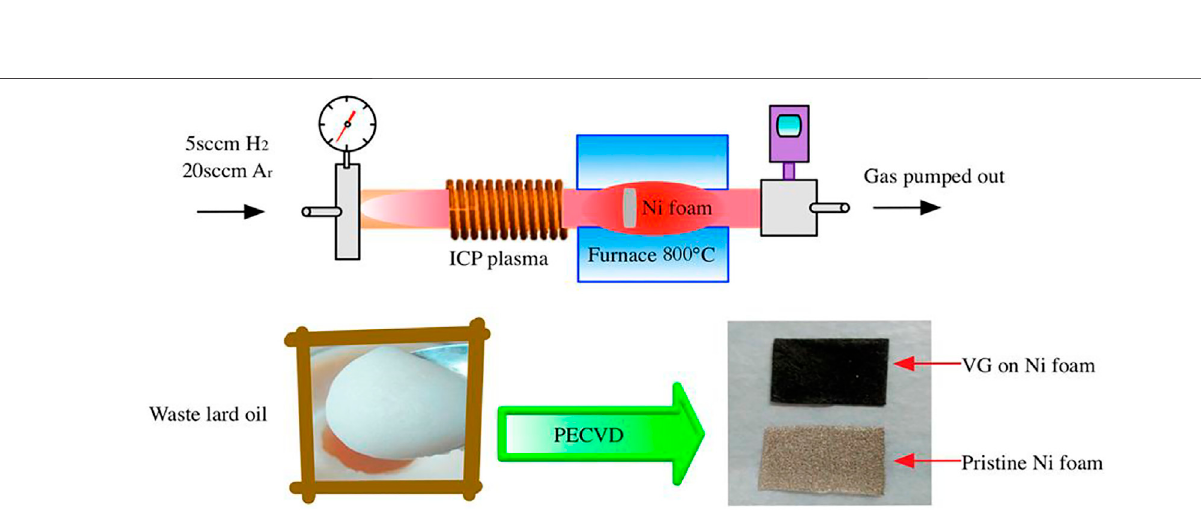
Frontiers in Nanotechnology |